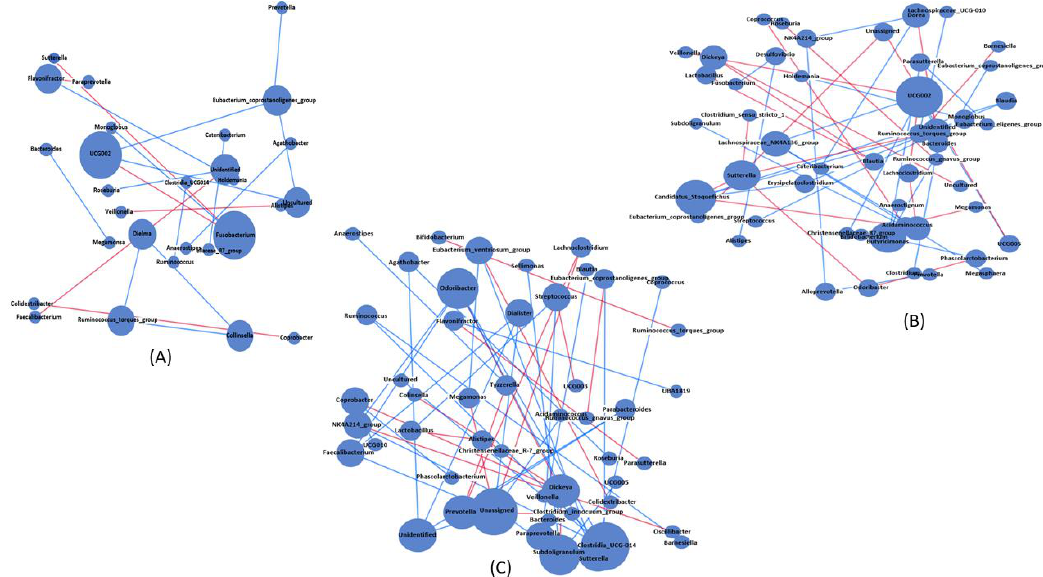
Figure 4. Genus-level bacterial association network analysis based on spearman among healthy controls ( A ), osteopenia ( B ), and osteoporosis ( C ). Nodes in blue color represent significant bacterial genera and lines connecting these genera indicate edges. The size of nodes represents interconnectedness among the genera. Lines with red color indicate positive correlations and red lines represent negative correlation.